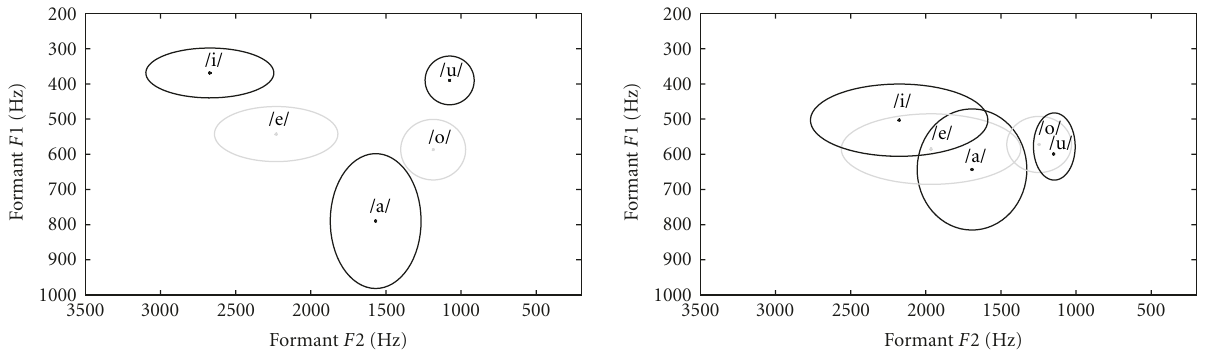
Figure 4: Formants map for the impaired speakers ) and excess Kurtosis ( γ ) values of the frame wise energy (SNR) in the reference 1 2